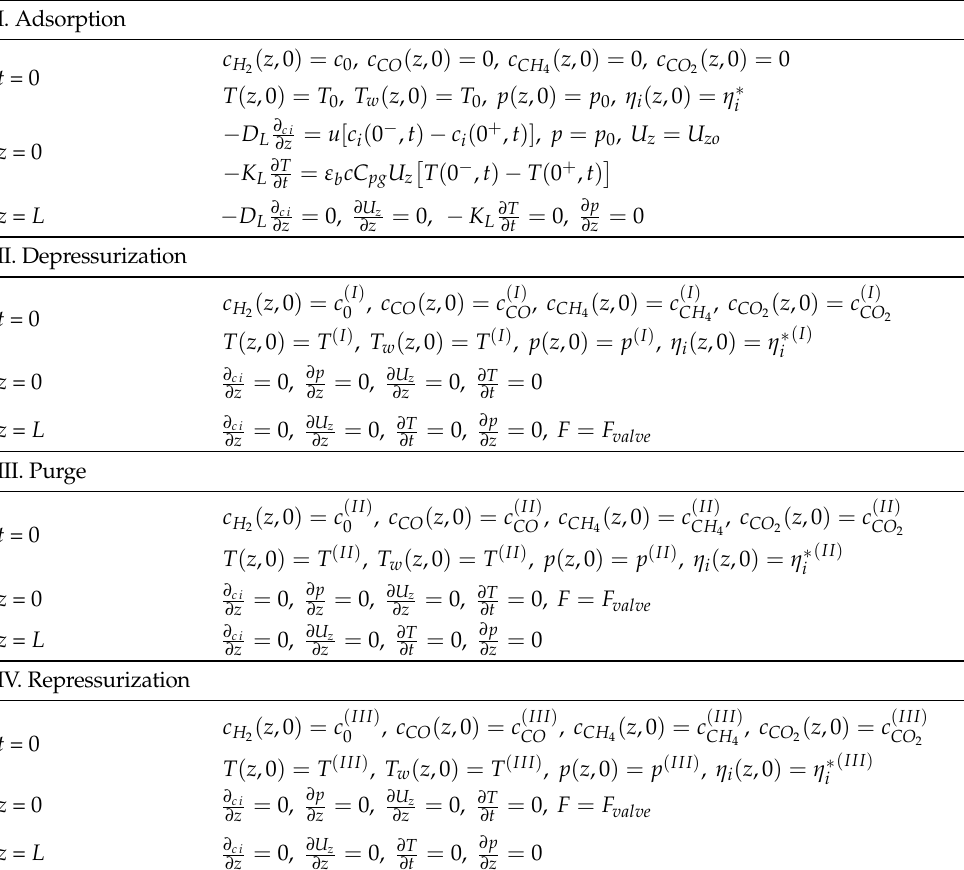
Table 2. Boundary and initial